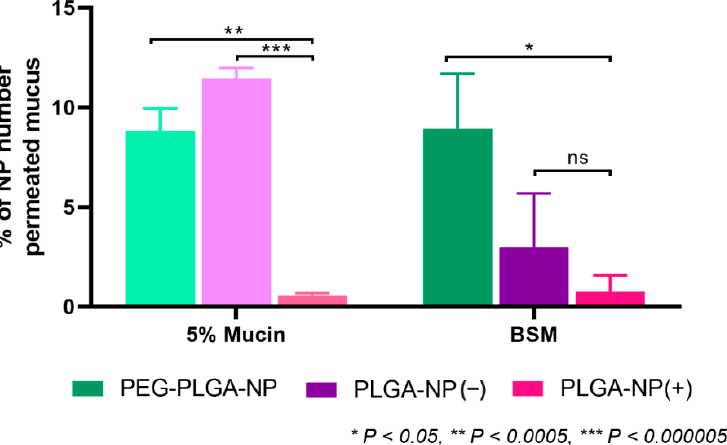
Figure 5. Quantification of the number of basolaterally permeated physicochemically diverse nano- particles of through model mucus barriers of 5% mucin and BSM after 6 h via Nanoparticle Tracking Analysis (NTA). Permeated nanoparticle number is normalised to the number permeating the bare semi-permeable Transwell membrane without the application of any mucus mimic. Non-significant data is designated ‘ns’.